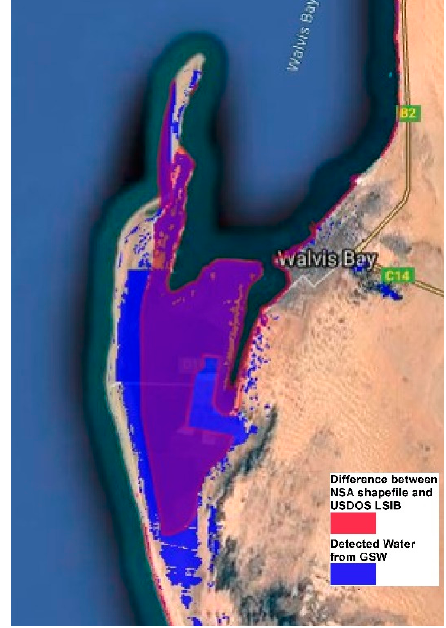
Figure 2. Comparison Boundaries of the United States Department of State Large Scale International Boundary (USDOS LSIB) vs. the Namibia Statistics Agency (NSA) shapefile at Walvis Bay (Erongo Region).